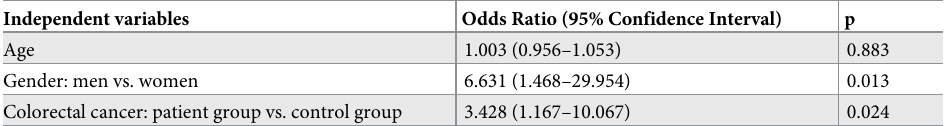
Table 5. Multivariate logistic regression results of associations between Cryptosporidium spp. infection and gen- der, age, and colorectal cancer diagnosis (both groups, n = 233). Independent